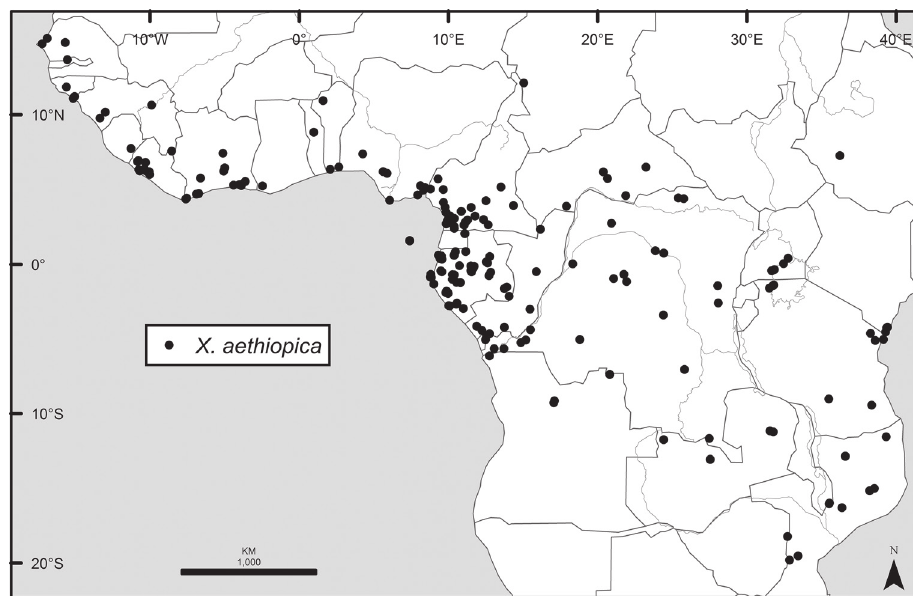
Figure 17. Distribution of Xylopia aethiopica . Bolder lines represent country borders, fainter lines lakes and major